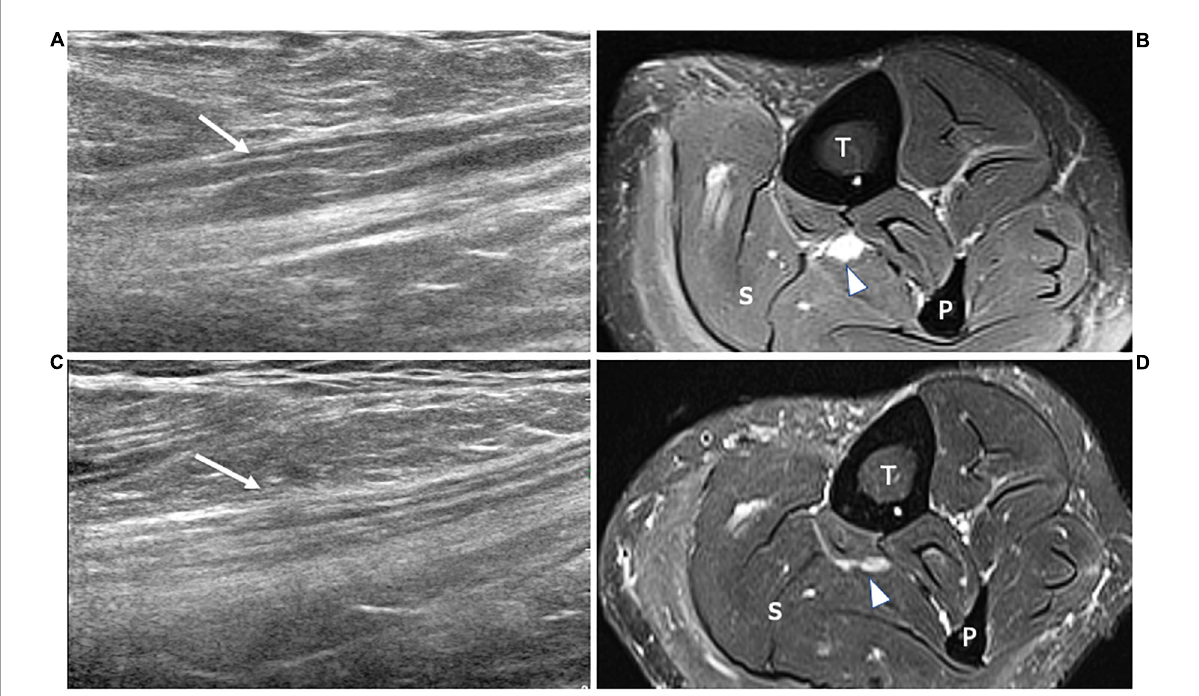
FIGURE5 This figure includes two 18 MHz HRUS images (A,C) and two T2-weighted with fat suppression axial MR images (B,D) in a 45 years old female patient affected by rheumatoid arthritis who developed a motor multifocal neuropathy of the tibial nerve after starting a treatment with the anti-TNF- α drug Etanercept. (A) The longitudinal scan of the tibial nerve at the proximal leg shows the focal enlargement of the nerve fascicles (white arrow) to which corresponds the T2-signal hyperintensity (white arrowhead) of the MR image in (B) . Both the nerve size and the T2-signal alteration, compatible with intraneural edema ensuing an inflammatory process, result markedly reduced in (B,D) . These latter were acquired after 6 months of therapy with immunoglobulin. The findings of this figure highlight the role of HRUS in monitoring the disease activity of dysimmune demyelinating neuropathies. T, tibia; F, fibula; S, soleus